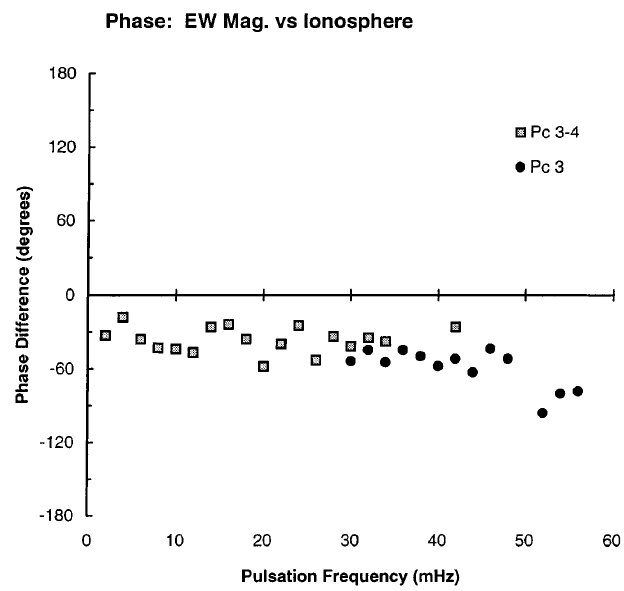
Fig. 7. Phase di(cid:128)erence between Doppler shift oscillations and EW component magnetic pulsations as a function of pulsation frequency, for Pc 3-4 events ( squares ) and regular Pc 3 ( solid circles